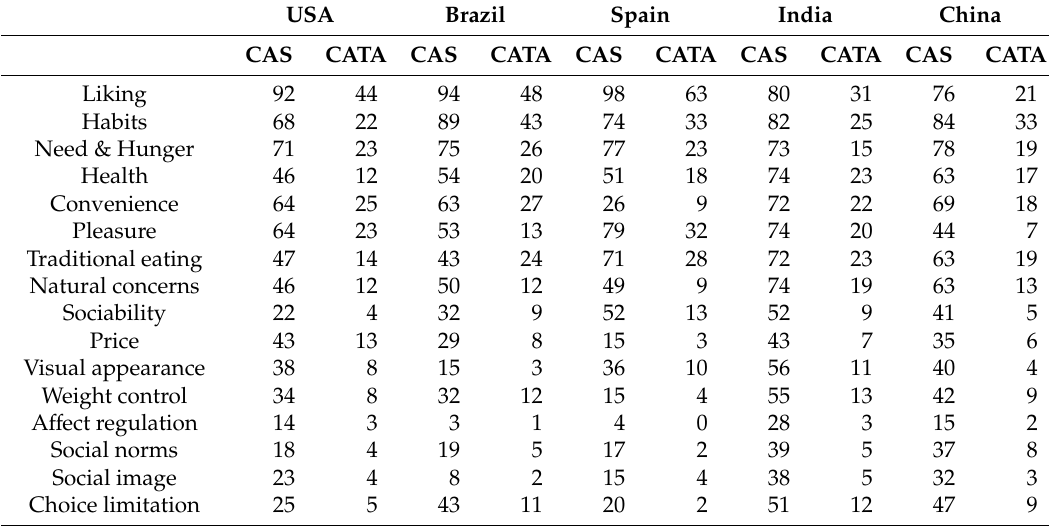
Table 4. Percentage of “agree” responses for CAS and CATA for all five countries for the respective starch-rich foods.